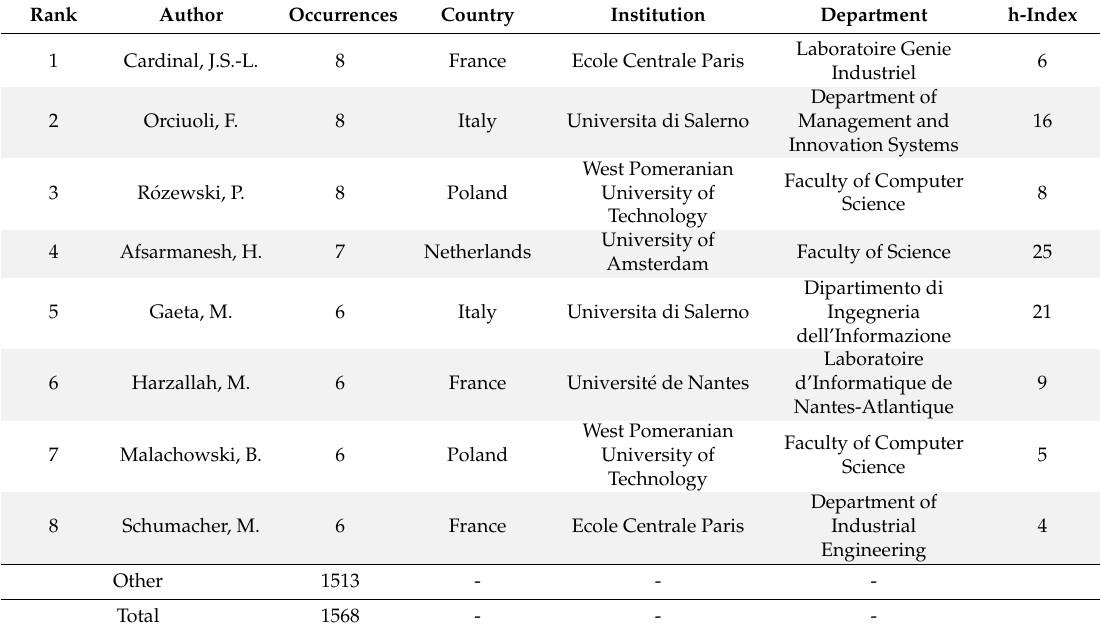
Table 9. Most productive authors in the field of competence-based